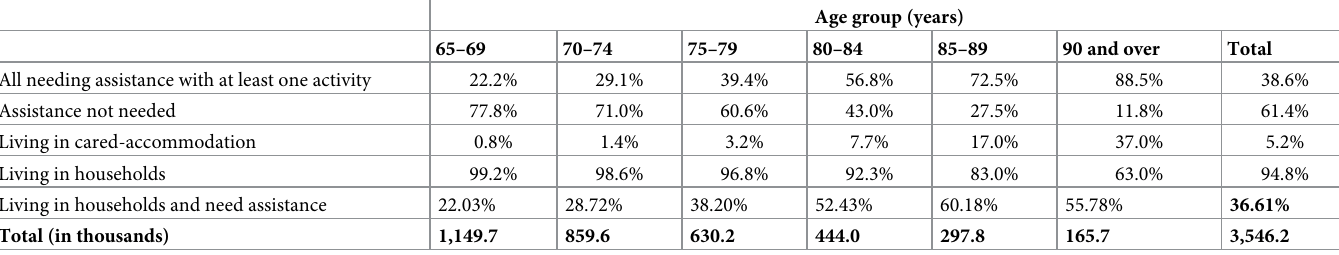
Table 2. Percentage of Australian population aged 65 years and over living in their own homes and requiring